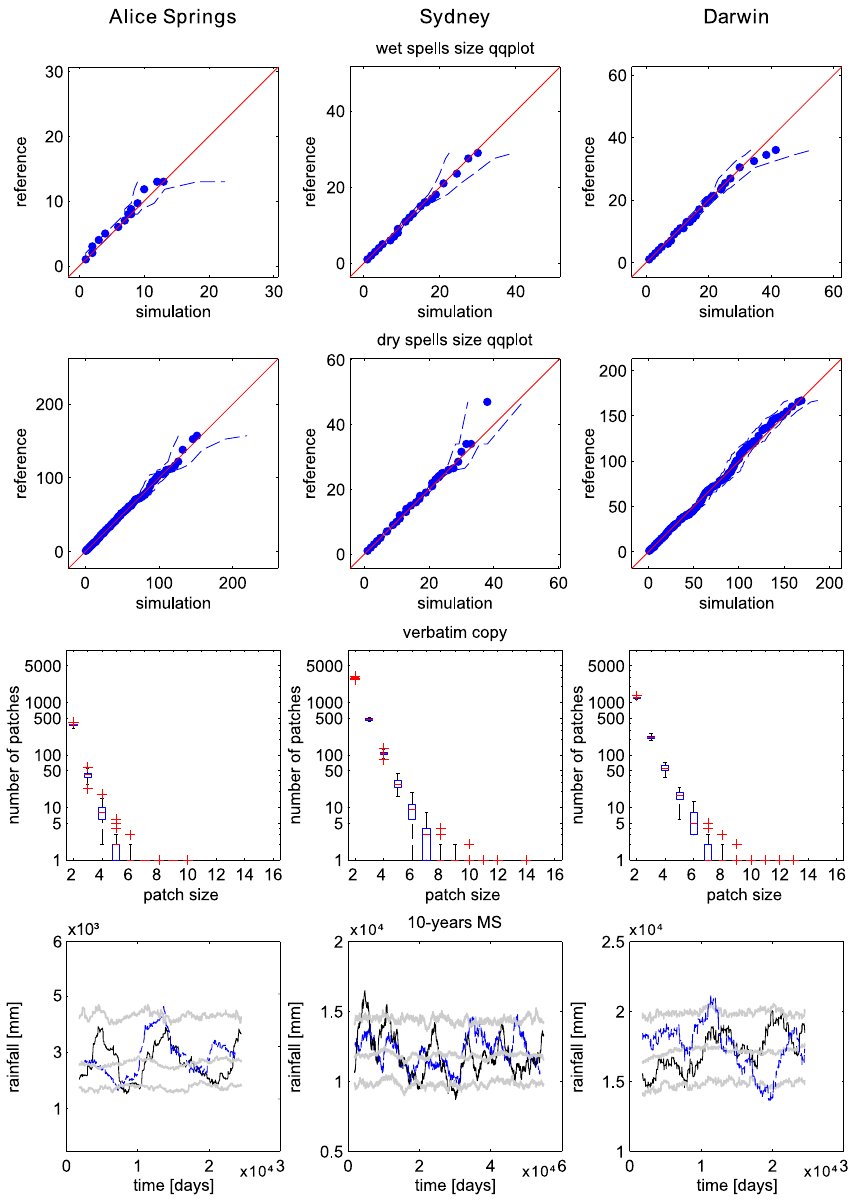
Figure 6. Main indicators describing the rainfall pattern: qq plots of the dry- and wet-spell (days) distributions, verbatim-copy box plots as function of the patch size (days) and daily 10-year MS time series (mm) of the reference (black line), median, 5th and 95th percentiles of the Fig. 6. Main indicators describing the rainfall pattern: qq-plots of the dry and wet spells [ days ] distributions, realizations (gray lines) and a randomly picked simulation (dashed blue verbatim copy box-plots as function of the patch size [ days ] and daily 10-years Moving Sum ( MS ) time-series [ mm ] of the reference (black line), median, 5-th and 95-th percentile of the realizations (gray lines) and a randomly picked simulation (dashed blue line).